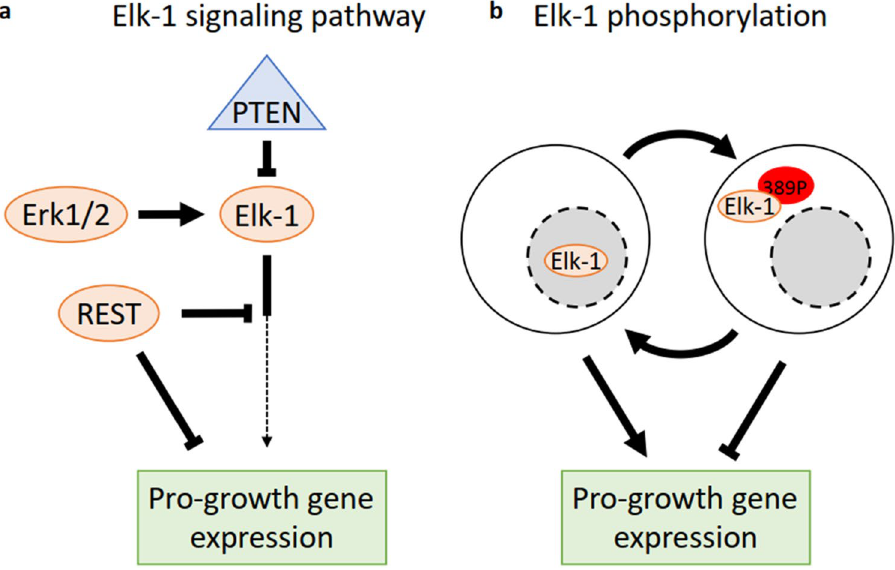
Figure 6. Integrated model of RGC growth promotion mechanism. ( a ) PTEN, an inhibitor of RGC survival and axon growth, is upstream of Elk-1 and inhibits Elk-1 expression, while Erk1/2 functions as an activator of Elk-1. While Elk-1 activity leads to the expression of pro-growth genes, REST may act as an inhibitor of this downstream pathway. ( b ) Elk-1 can either promote growth or inhibit growth based on phosphorylation of the S389 site. Phosphorylation of S389 leads to more cytoplasmic localization of Elk-1 and less pro-growth gene